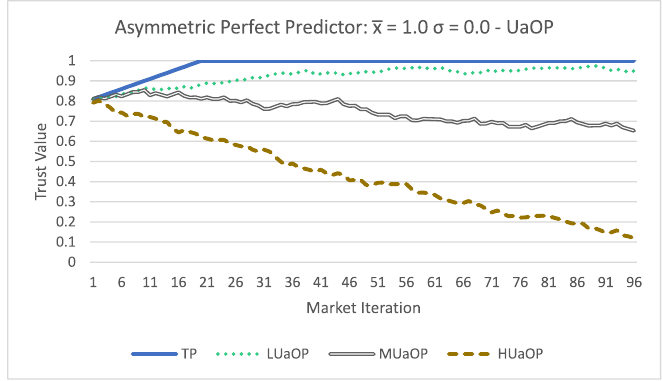
Figure 3. Asymmetric perfect predictor.